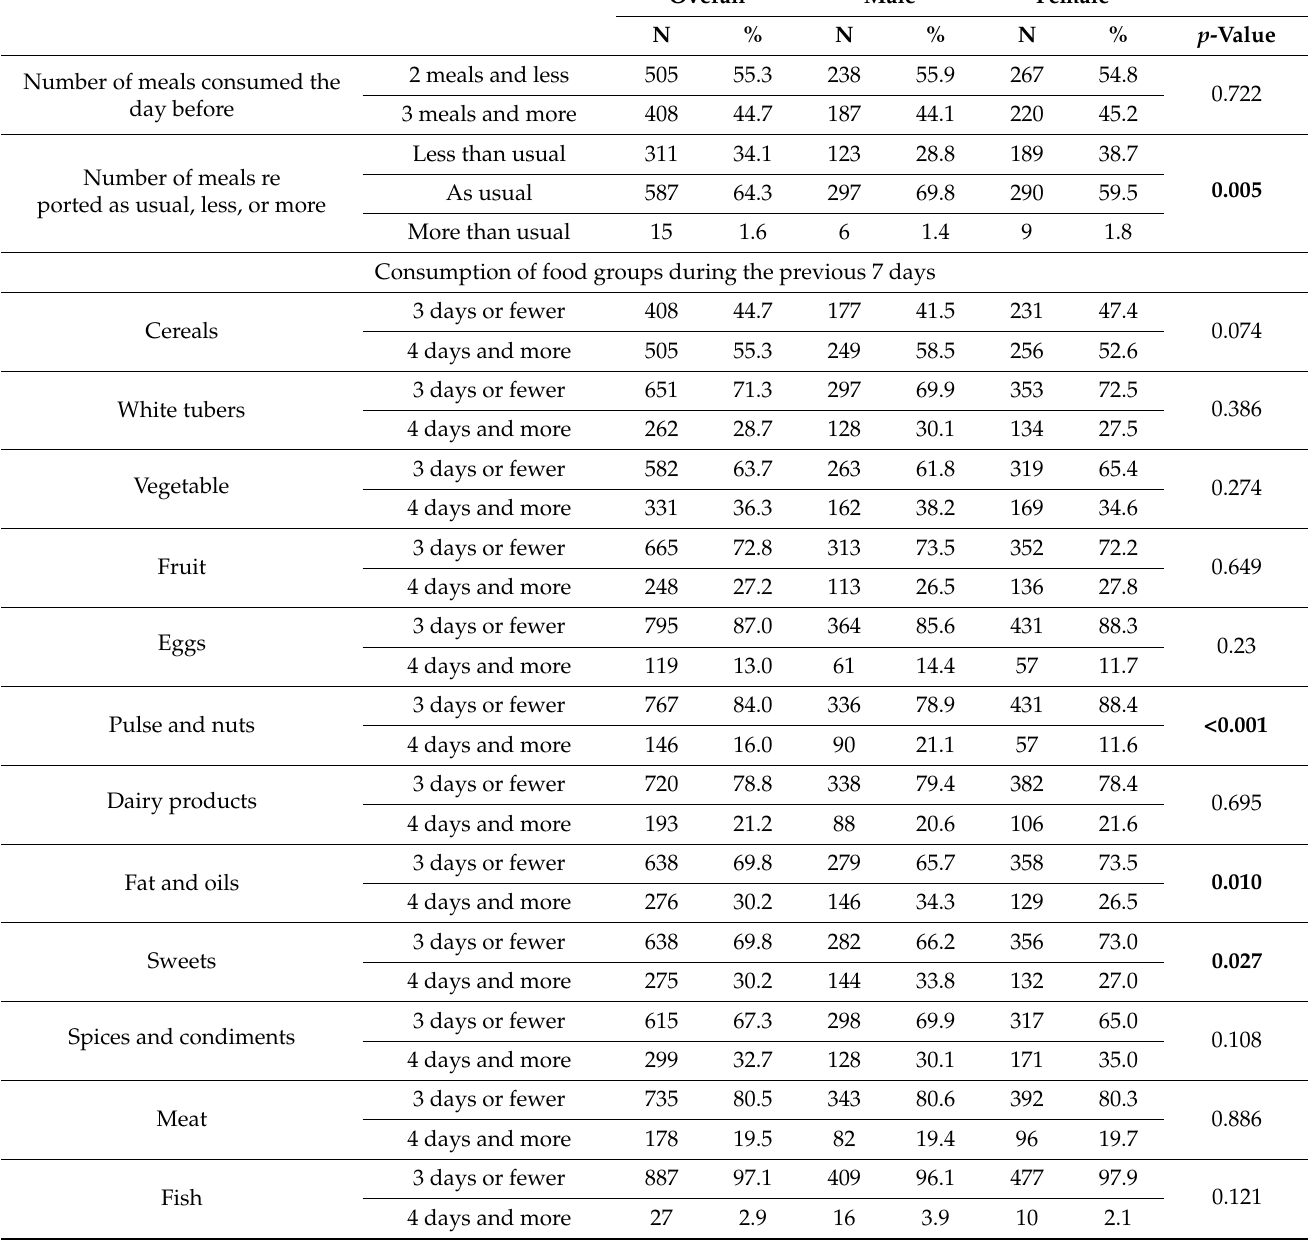
Table 2. Food groups consumption per week in overall population and by